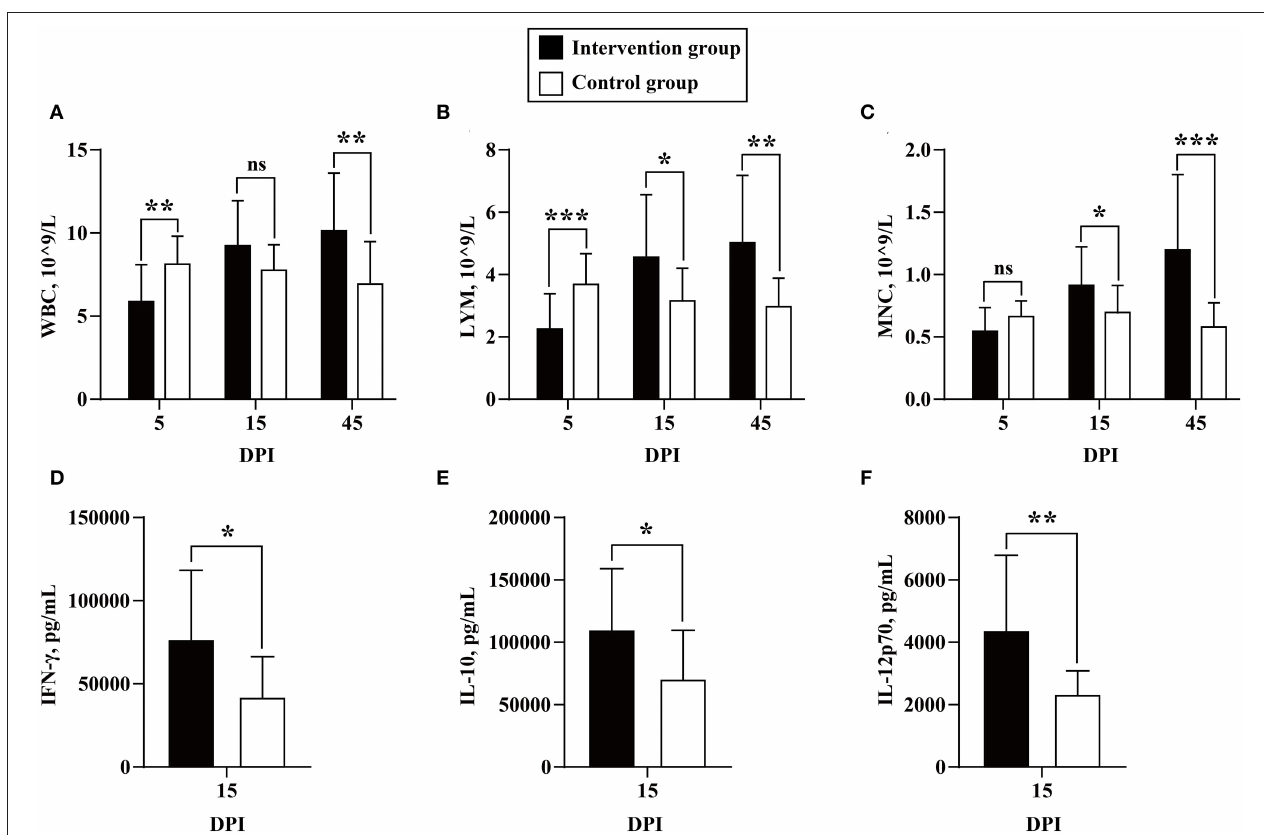
FIGURE 2 | Quantification of CBC parameters and cytokines. The numbers of white blood cells (WBCs) (A) , lymphocytes (LYM) (B) , and monocytes (MNCs) (C) were compared between cows in the intervention (in black) and control (in white) groups at 5, 15, and 45 DPI. The expression levels of IFN- γ (D) , IL-10 (E) , and IL-12p70 (F) were compared between the cows in the inoculation (in black) and control (in black) groups at 15 DPI. Data are shown as mean ± SD, and the symbols indicate P ≤ 0.001 (***), P ≤ 0.010 (**), P ≤ 0.050 (*), and P > 0.050 (ns), respectively.